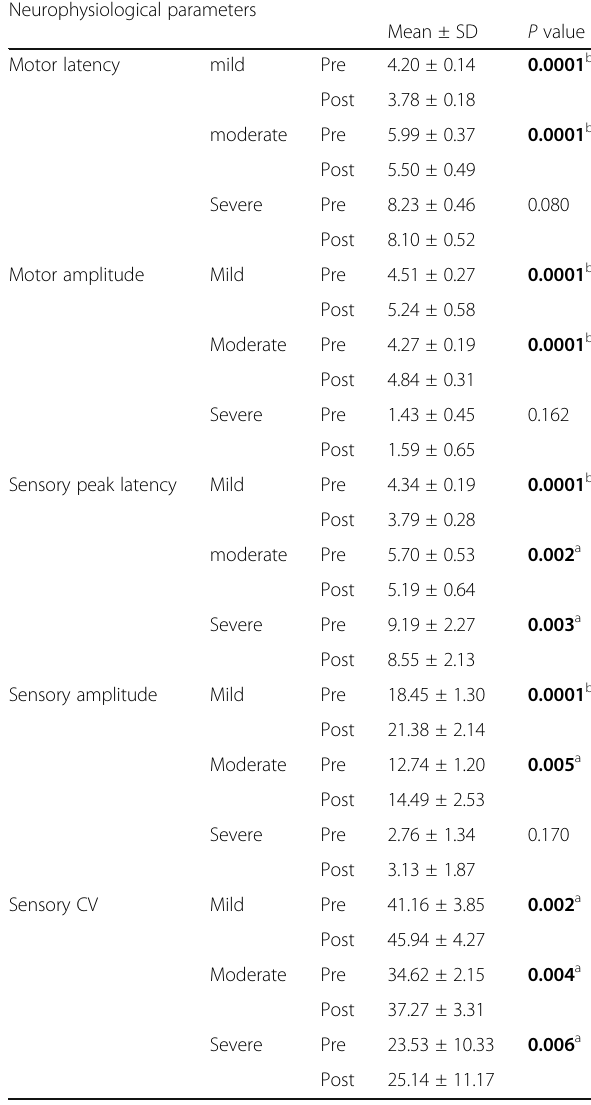
Table 3 comparison between pre- and post-neurophysiological parameters within mild, moderate, and severe groups Neurophysiological